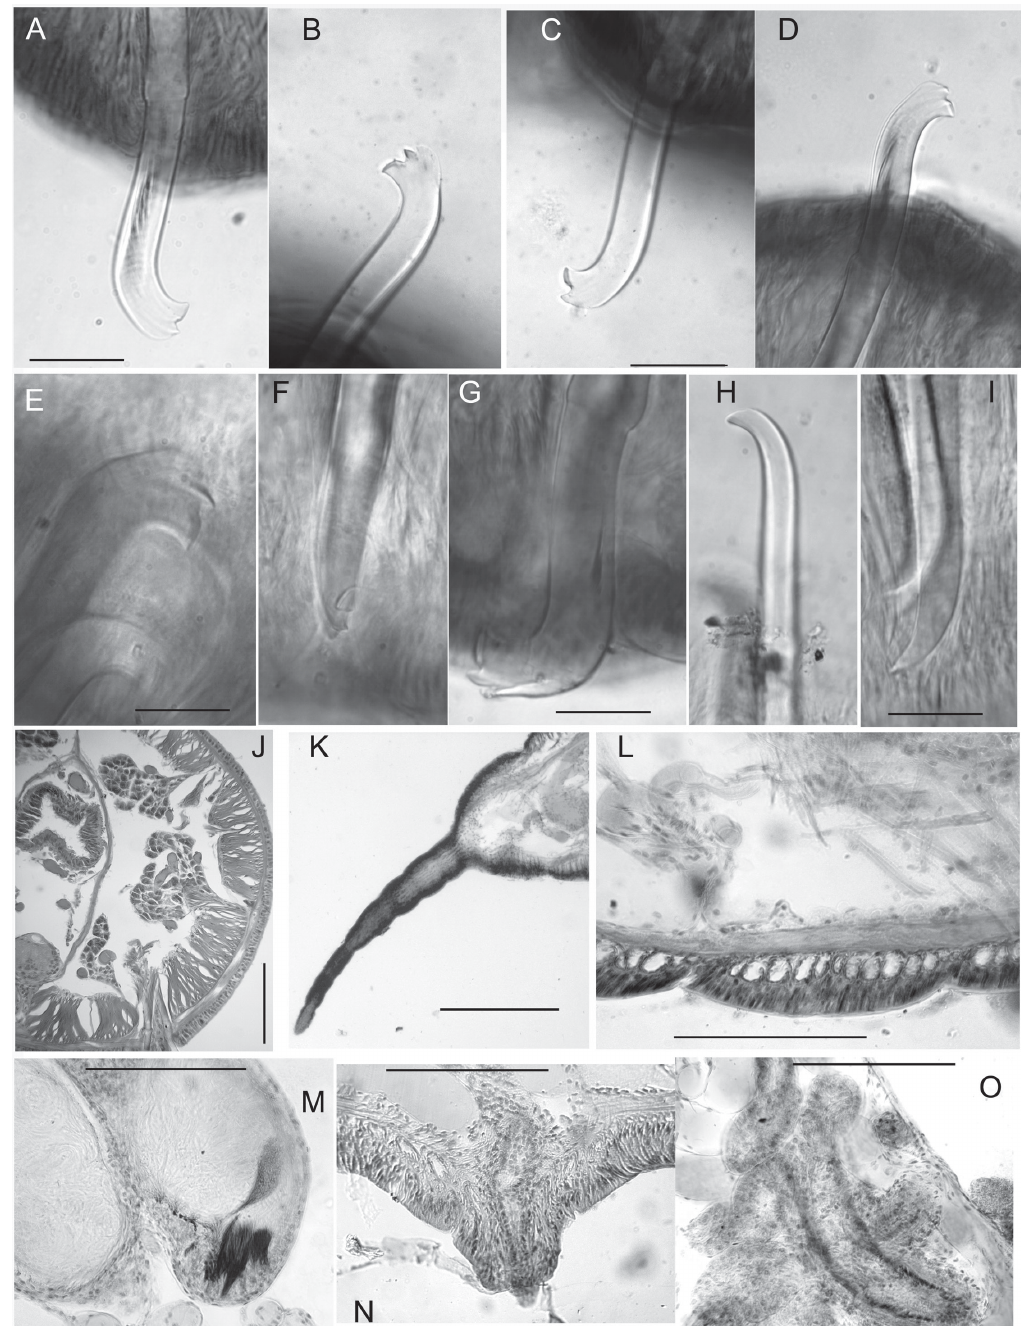
Fig. 2. Kincaidiana hexatheca Altman, 1936 from various sites. A, K–O from the sagittally sectioned lectotype, Loomis Lake, WA; B–C from Hoh River, WA; D from Inglenook Fen, CA; E–I from Big Creek, OR; J from O’Brien, OR. A-I . Tips of chaetae in anterior segments. A . IV ventral. B . VI dorsal. C . V ventral. D . V dorsal. E . IV dorsal. F . V ventral, frontal view. G . V ventral, chaeta with keel folded over. H . Dorsal, posterior segment. I . XV, ventral. J . Transverse section of anterior segment, showing 3-lobed pharyngeal gland. K . Ringed proboscis. L . Body wall in anterior segment, showing bands of circular muscle. M . Spermathecal ampulla, with concentrated sperm. N . Male porophore and penis. O . Atrium, prostate glands and vas deferens. Scale bars: A–I = 50 µm; J, L–O = 200 µm; K = 500